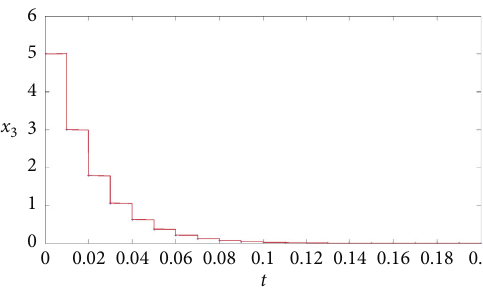
Figure 9: The trajectory of the state x coefficients a � 35, b � ( 8/3 ) , c � 25, t k � 0 . 01 k ( k � 1 , 2 , ... , ) , d � 0 ( i,j � 1 , 2 , 3 ,i ≠ j ) , and d ij condition x ( 0 ) � ( 3 , 4 , 5 ) T .